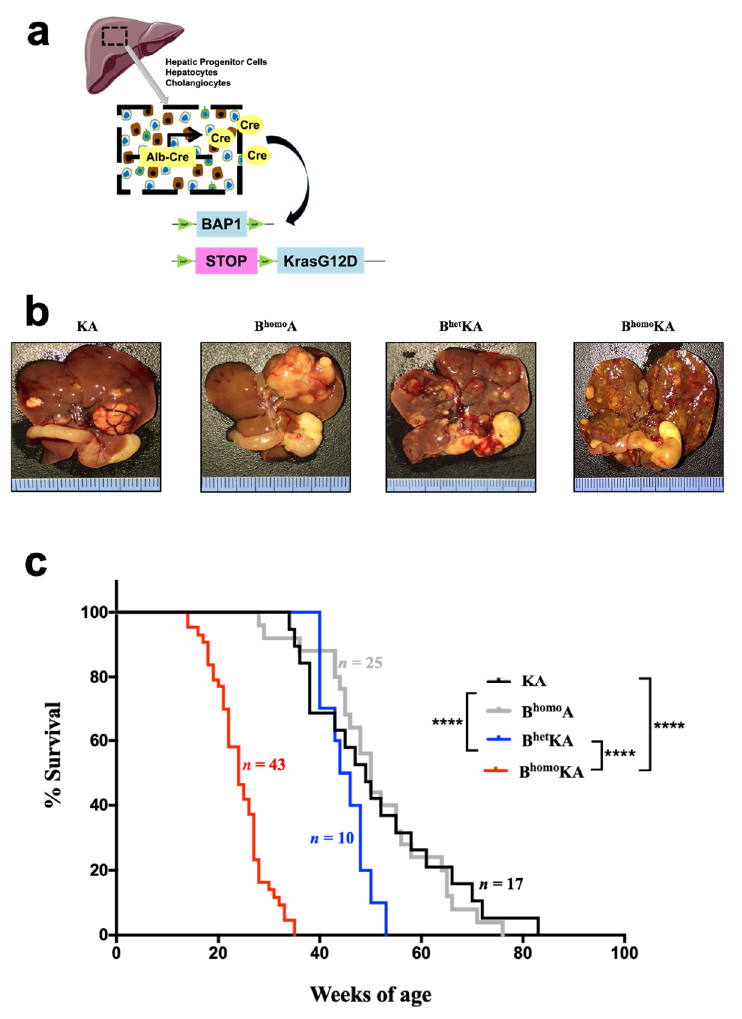
Figure 1. Mice with constitutional KrasG12D activation and BAP1 deletion in the hepatic epithelium develop primary liver tumors. ( a ) Modeling strategy to generate compound mutant mice. Mice harboring Albumin -Cre transgene, Lox-STOP-Lox- Kras G12D , and BAP1 L/L were created to conditionally activate Kras G12D and delete BAP1 in the hepatic epithelium; ( b ) in situ gross tumor nodules throughout the hepatic parenchyma with associated hepatomegaly in experimental cohorts; ( c ) Kaplan–Meier survival analysis for KA ( n = 17), B homo A ( n = 25), B het KA ( n = 10), and B homo KA ( n = 43) cohorts. Two-tailed unpaired Student’s t-test was used for data analysis and considered significant if ****, p < 0.0001.